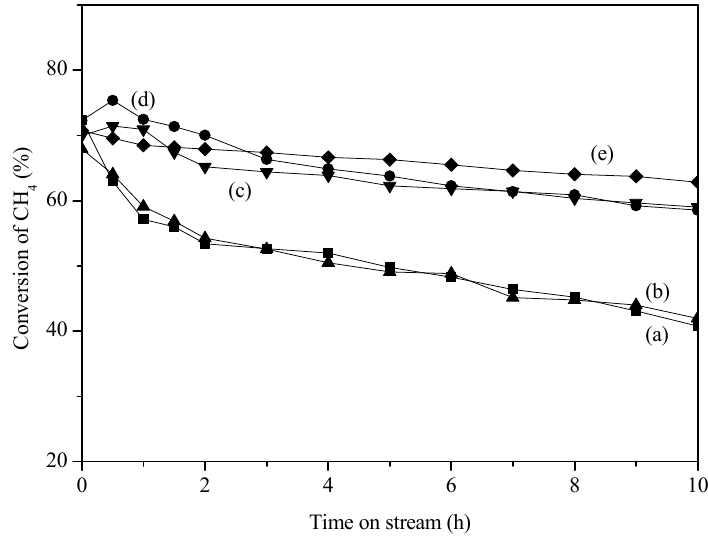
O ; ( b ) Pd/MgO/Al 2 3 O . 2 3